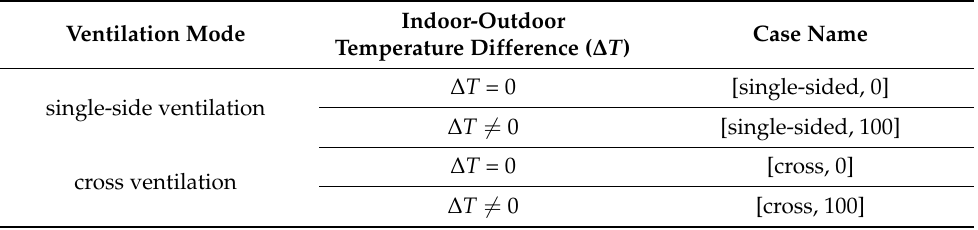
Table 1. Scenarios tested with different ventilation modes and indoor-outdoor temperature